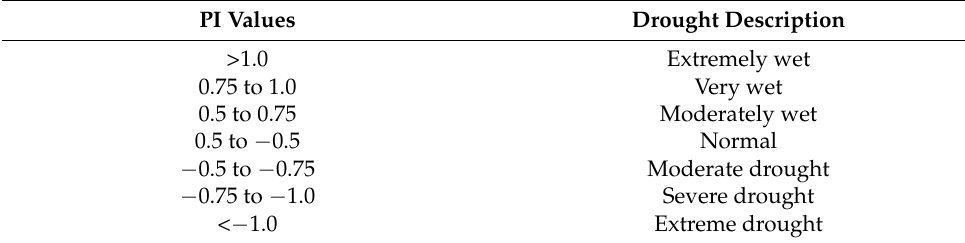
Table 2. Classification of drought based on PI [13].